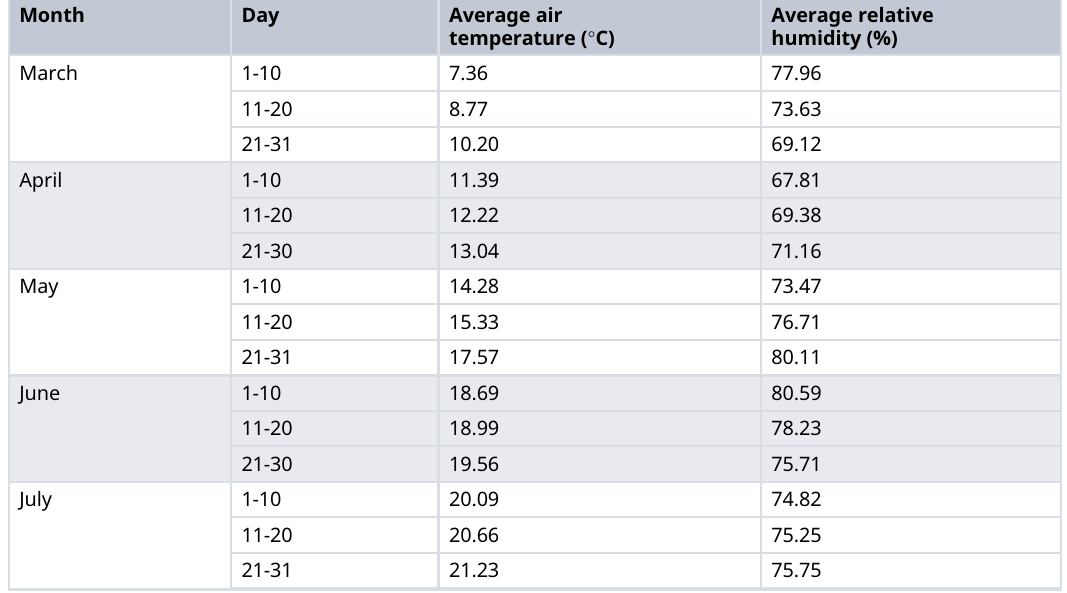
Table 3. Air temperature and relative humidity in 2020